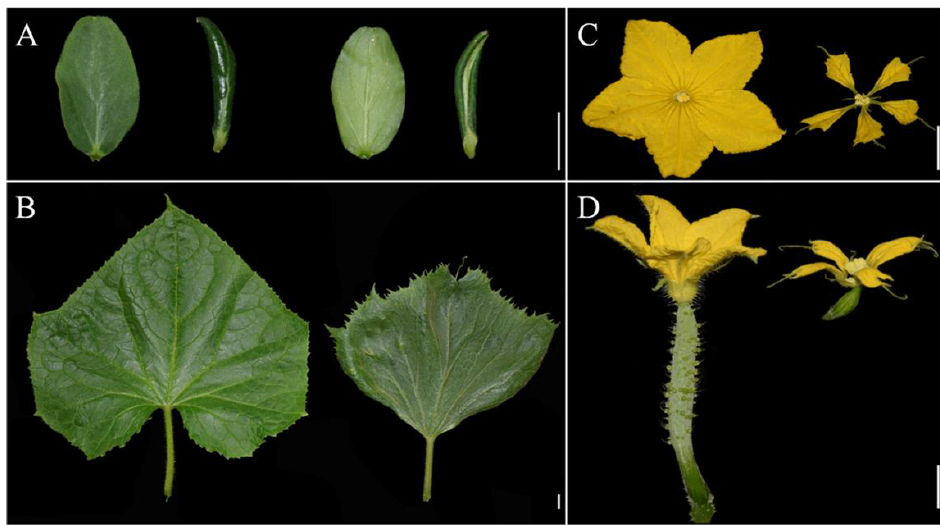
Figure 3. Phenotypic features of odd1 . ( A , B ) The contrast of cotyledon and true leaf between WT ( left ) and odd1 ( right ) at same developmental stage. ( C ) The male flower and ( D ) female flower at anthesis (left: WT; right: odd1 ). Scale bars represent 1 cm.